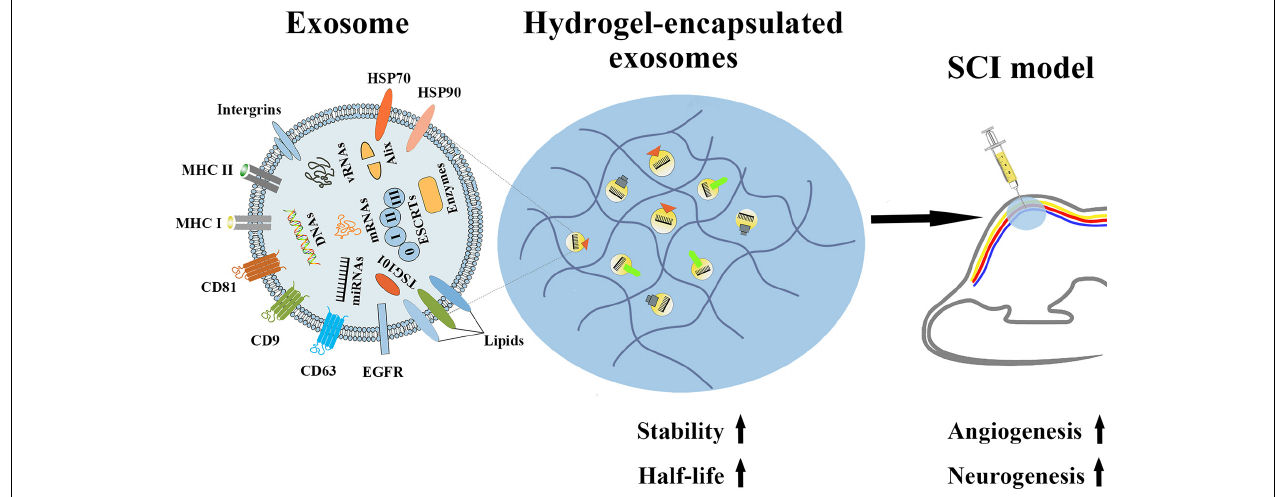
FIGURE 4 | The properties of hydrogel-encapsulated exosomes and their potential functions in SCI. Hydrogel-encapsulated exosomes have the characteristics of higher stability and a longer half-life, and can promote angiogenesis and neurogenesis after